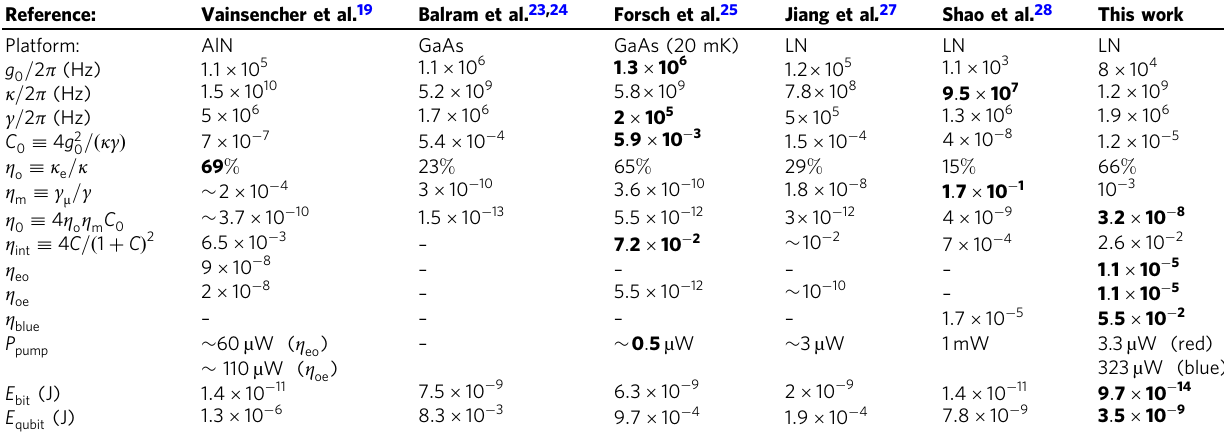
γ μ is de fi ned as the decay rate from the local mechanicalmode to the 50 Ω microwave channel. Optical-to-microwave ( η separately. We note that only the demonstrations on LN platform are in the sideband-resolved regime, and the corresponding E bit is calculated differently (see the main text). The values most favorable for ef fi cient conversion are highlighted in